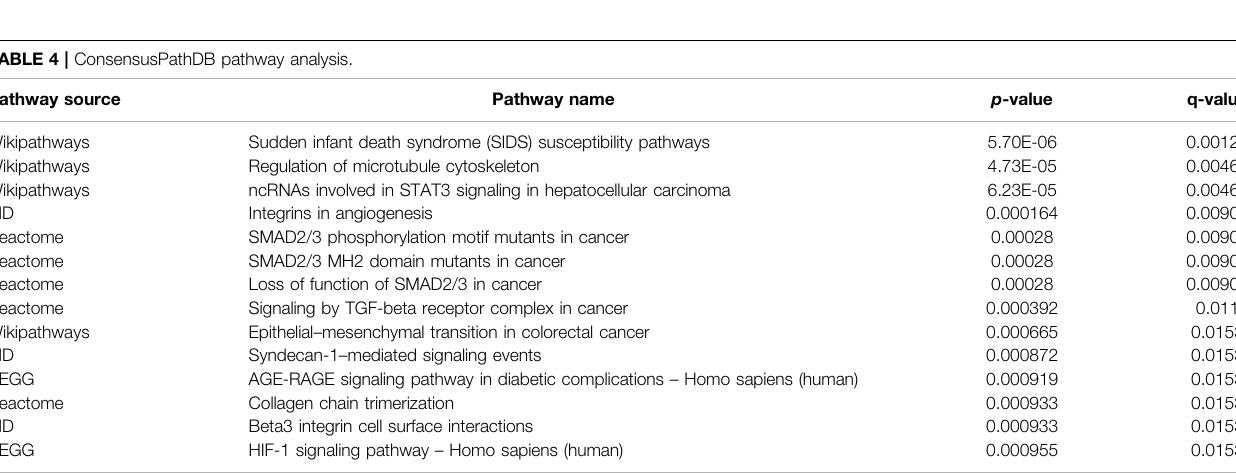
TABLE 4 | ConsensusPathDB pathway